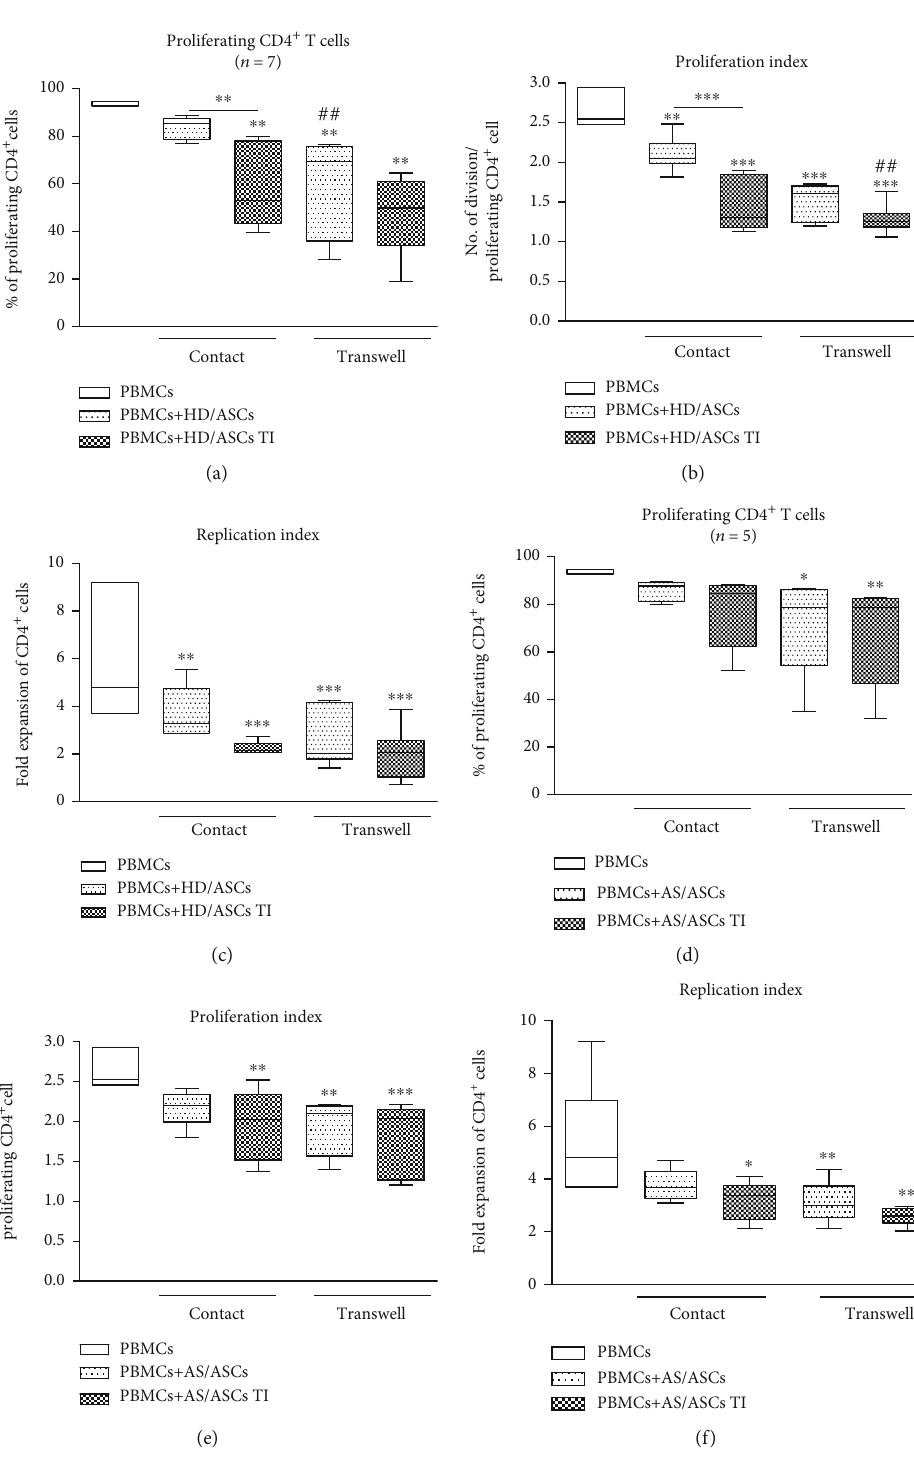
Figure 2: Comparison of ASC inhibitory e ff ects on CD4 + T cell proliferation in contact and transwell cocultures. PBMCs, isolated from 3 healthy blood donors and activated with PHA, were cultured separately (control) or cocultured with ASCs from 4 healthy donors (HD/ASCs) or 5 AS patients (AS/ASCs) in conditions allowing direct cell contact or in a transwell system. Untreated and TNF+IFN γ - (TI-) treated ASCs were used. The proliferation of CD4 + T cells was analyzed by fl ow cytometry. Data are the results of the indicated number of experiments ( n ) and are shown as the Tukey ’ s boxes. ∗ P = 0 : 05 ‐ 0 : 01 , ∗∗ P = 0 : 01 ‐ 0 : 001 , and ∗∗∗ P = 0 : 001 ‐ 0 : 0001 for comparison of cell cocultures vs. control separate cultures and as indicated. ## P = 0 : 01 ‐ 0 : 001 for comparison of contact vs. transwell